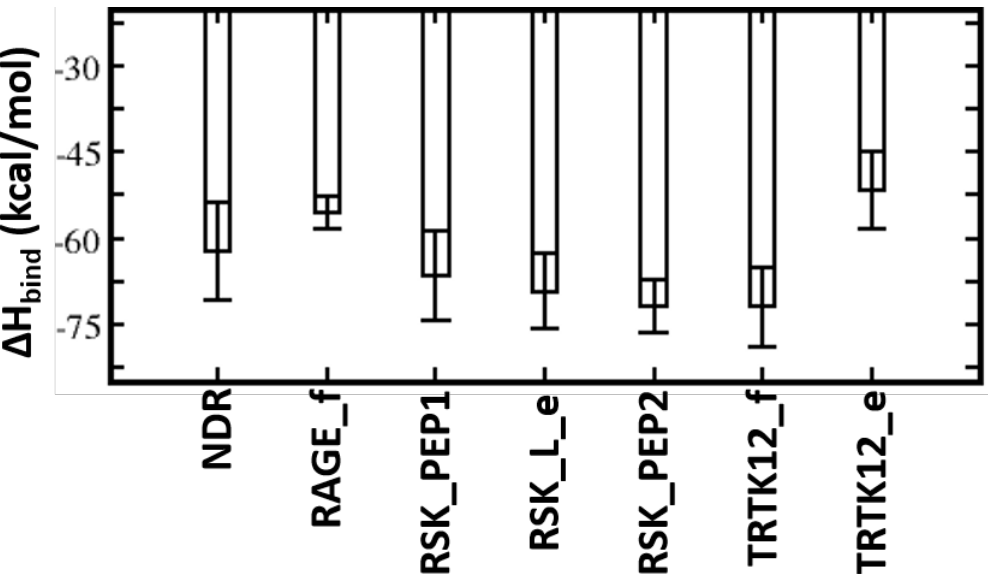
Figure 4. Energetic analysis of the molecular dynamics (MD) simulations of the S100B( ββ )–peptide complexes. Binding free energies of the interactions of S100B( ββ ) with each peptide were calculated using the MMPBSA approach (see Methods) using the conformations sampled during the MD simulations of the S100B( ββ )–peptide complexes.